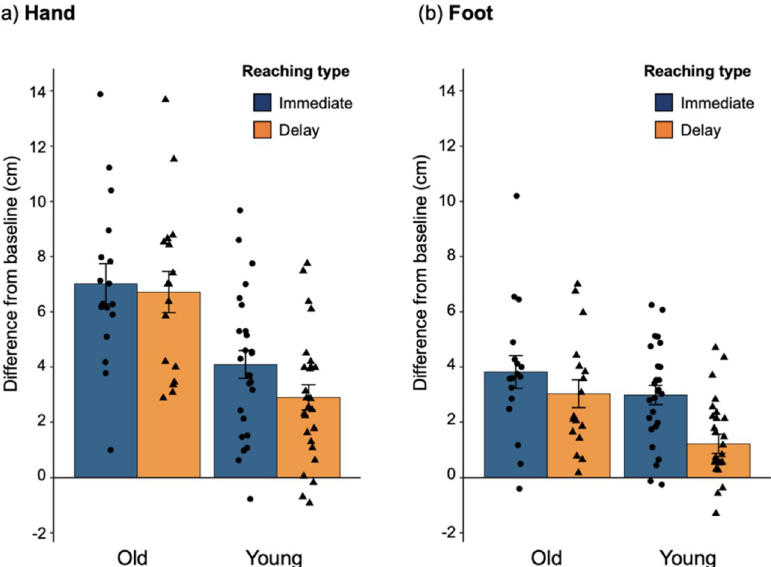
Figure 3. Reaching error in the hand and foot conditions for older ( N = 17) and young adults ( N = 26). Reaching errors were calculated by subtracting reaching positions in the baseline condition from those in the immediate and delay conditions. Negative and positive values indicate the reaching errors in the direction of the mirror and its opposite direction, respectively. Dots indicates individual data. Error bars denotes the standard error of the mean. Plots were generated using R software version 4.0.5 (R Core Team (2021). R: A language and environment for statistical computing. R Foundation for Statistical Computing, Vienna, Austria. http:// www.R- proje ct.